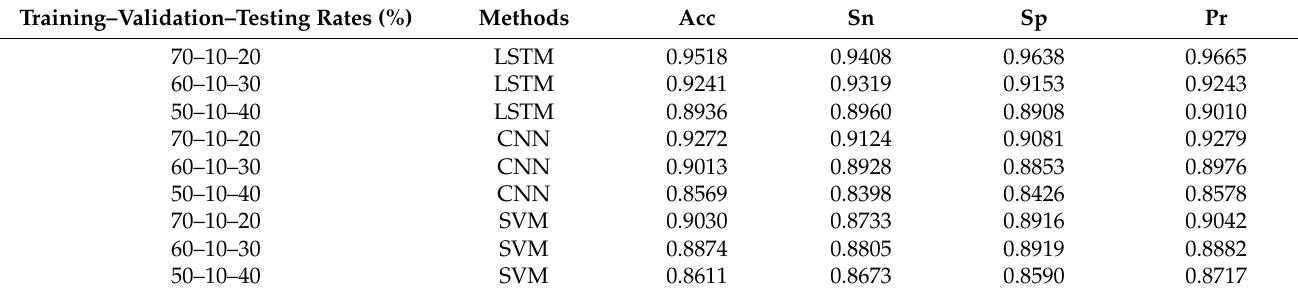
Figure 9. The graphs of accuracy and loss values for the LSTM training and validation. Table 3. Performance criteria for training–validation–testing